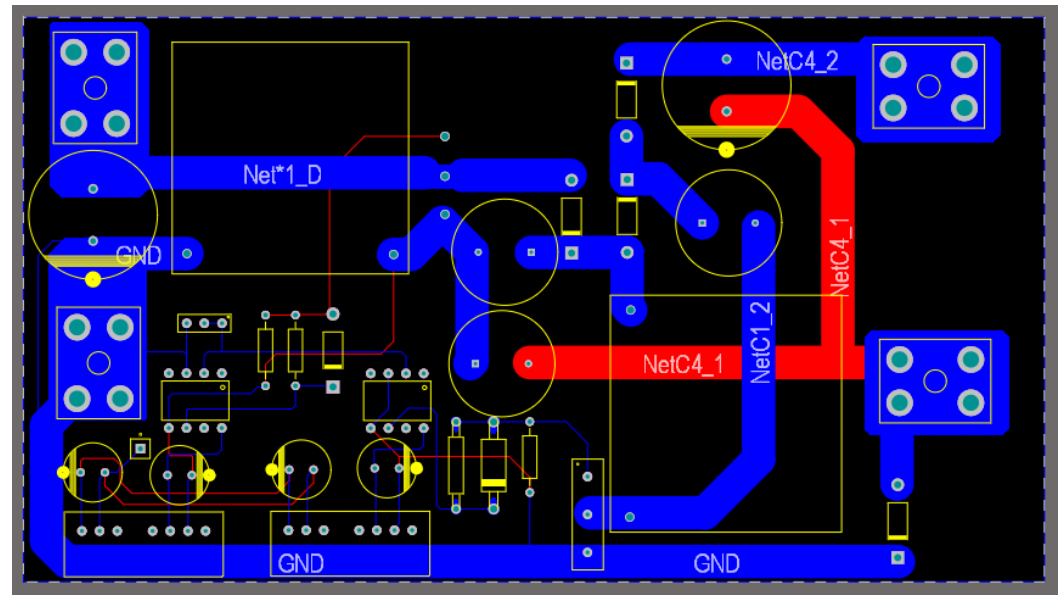
11 of 19 Figure 11. Output voltage and voltage stress across switch S 1 and S 2 at D = 0.4. 5.2. Experimental Verification The hardware prototype is developed on the power circuit board (PCB) by using Altium Designer software. The designed PCB layout is shown in Figure 12. The hardware prototype is shown in Figure 13a, and the experimental setup is shown in Figure 13b. The specifications of the developed hardware prototype are shown in Table 3. The theoretical and simulation results are confirmed by developing a prototype and of 150 W in the lab. Figure 14 shows the experimental waveform of the